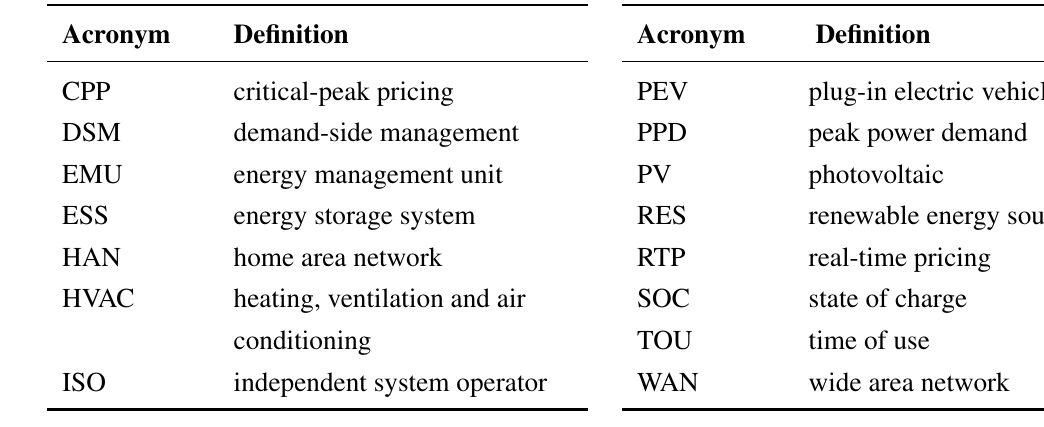
Table 1. The main acronyms used in the demand-side management research